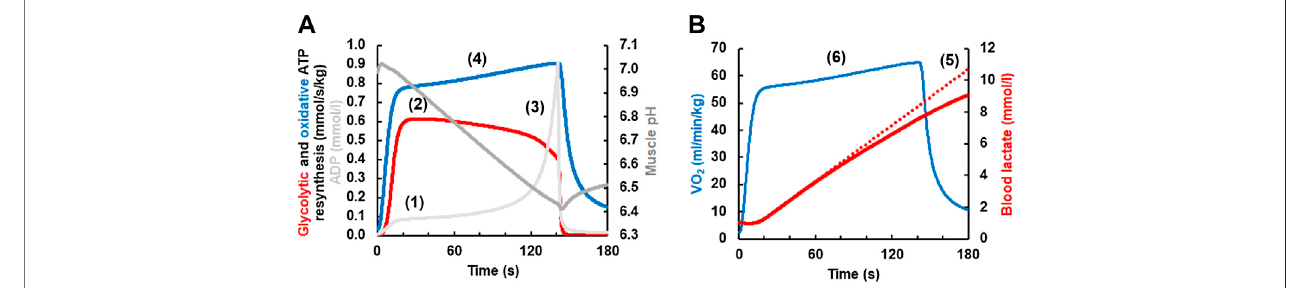
FIGURE 4 | (A) Simulation of the V _ O 2 slow component simulated with a current version of the Mader human exercise metabolism model. At the onset of exercise, the concentrations of ADP and AMP (not shown) increase (1) . This stimulates phosphofructokinase and thereby increases the rate of glycolytic ATP resynthesis and lactate formation, reaching a maximum in-between 20 – 40 s (2) . As the concentration of muscle lactate increases (B) , muscle pH becomes increasingly acid from ≈ 20 s onwards (3) . As an acid pH inhibits phosphofructokinase (Panel 4A) and thereby glycolytic ATP resynthesis, the rate of glycolytic ATP resynthesis declines after its maximum in-between ≈ 20 – 40 s even though the concentrations of ADP and AMP (not shown) rise greatly just before fatigue. Because glycolytic ATP resynthesis declines, oxidative ATP resynthesis must rise to meet the constant ATP hydrolysis during constant load exercise (4) (the contribution of ATP resynthesis from phosphocreatineisincorporatedinthemodelbutnotshown).Iftheef fi ciencywouldworsen,thentheslowcomponentwouldincreasefurther.Panel4BOnawholebody level,thereductionintherateofglycolyticATPresynthesisandlactateformationisseen (5) asalessthanlinearincreaseofthelactateconcentration(thedottedlineplots an increase of lactate at the rate that is reached in-between 20 – 40 s). The slow component of oxidative ATP resynthesis in (A) is seen as a corresponding slow component of the V _ O 2 in (B) (6) .